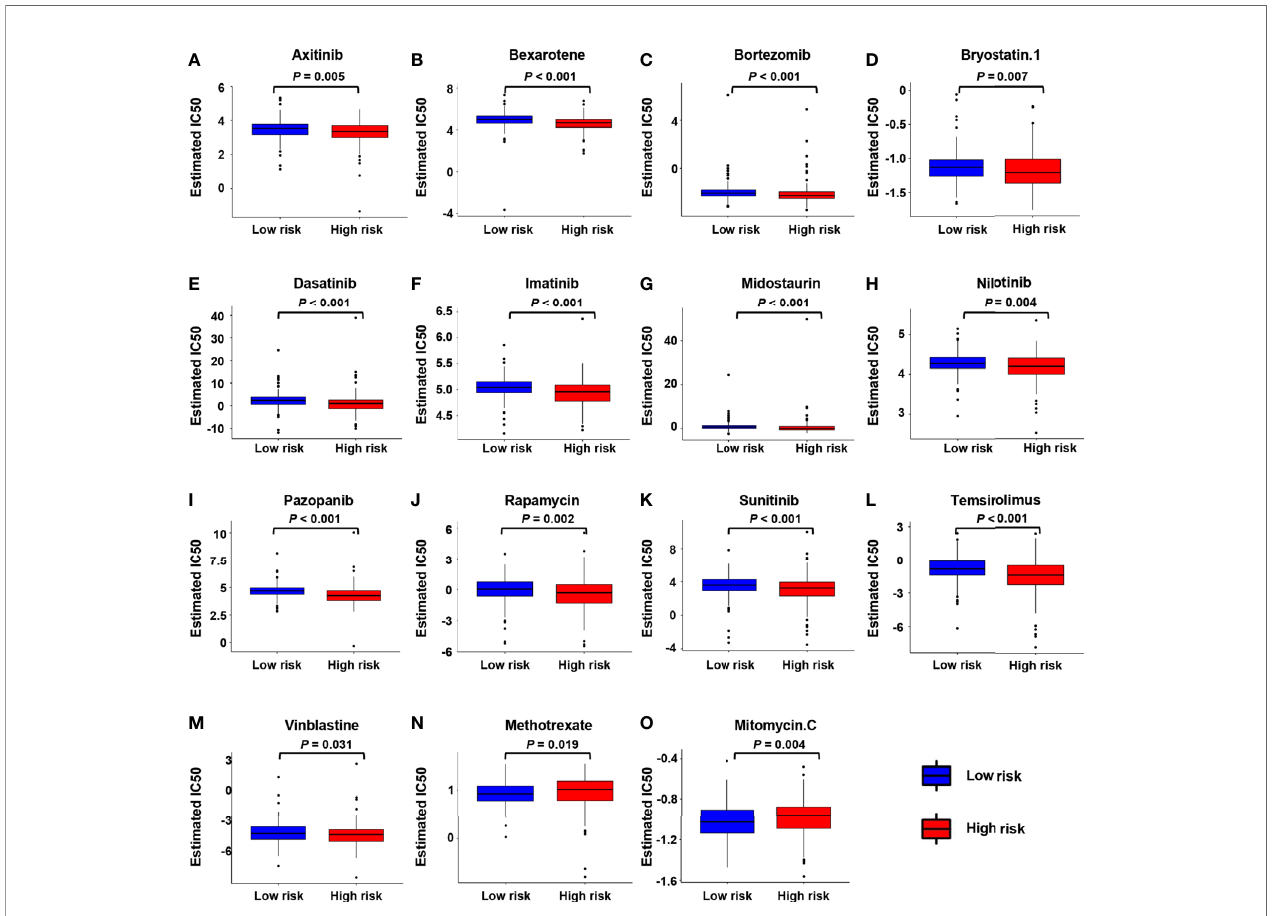
FIGURE 7 | The correlation between low-risk and high-risk groups and chemotherapeutics. Sensitivity to chemotherapeutic drugs is expressed by the half inhibitory centration (IC50) of chemotherapeutic drugs. (A) Axitinib; (B) Bexarotene; (C) Bortezomib; (D) Bryostatin.1; (E) Dasatinib; (F) Imatinib; (G) Midostaurin; (H) Nilotinib; (I) Pazopanib; (J) Rapamycin; (K) Sunitinib; (L) Temsirolimus; (M) Vinblastine; (N) Methotrexate; (O)